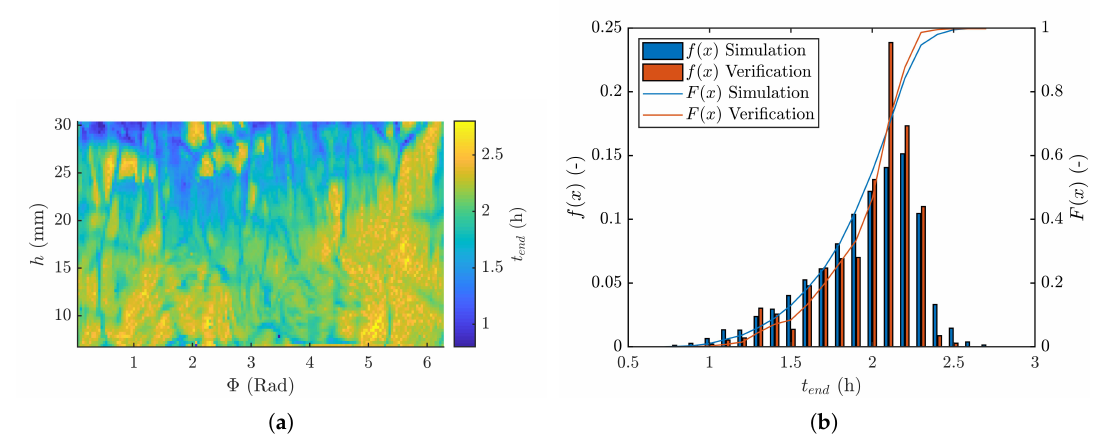
Figure 8. ( a ) Distribution of primary drying endpoint ( t end ) for a simulation of a spin-freeze dried 10R vial with 3.5 ml 4% BSA formulation at a chamber pressure of 10 Pa and total power towards the vial of 1.2 W and ( b ) End of primary drying ( t end ) histograms ( f ( x ) —left axis) and cumulative distribution ( F ( x ) —right axis) for both the simulation (Section 3.4) and the verification (Section